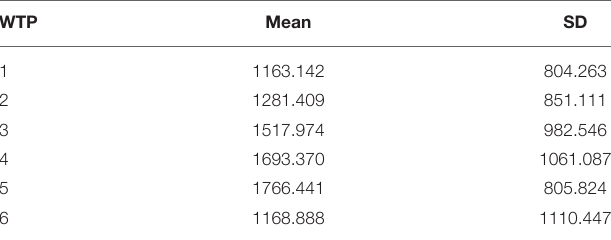
TABLE 7 | Descriptive statistics for the evaluation levels of the WTP